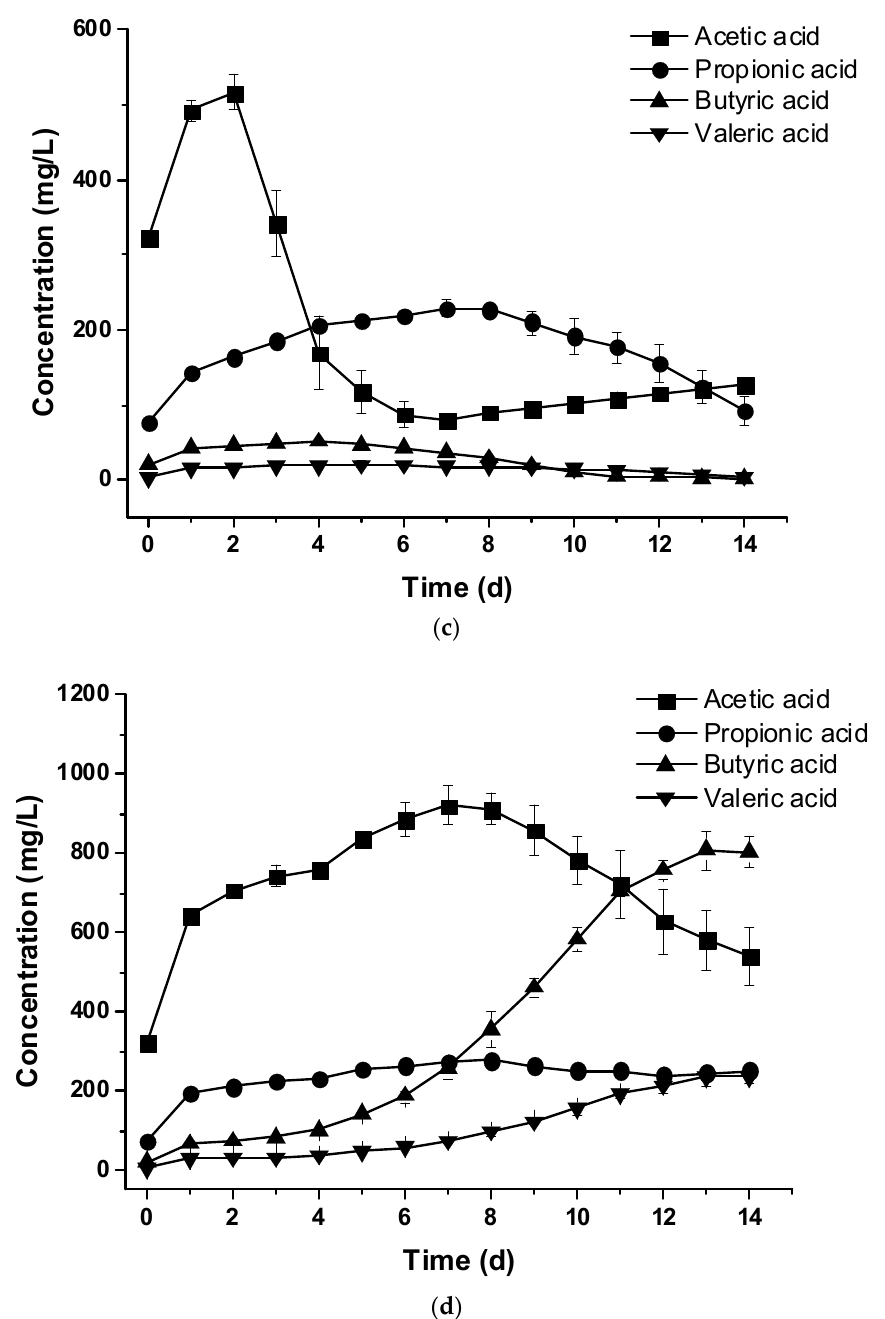
Figure 6. Changes of accumulated volatile fatty acid without ( a ), with 2% ( b ), 4% ( c ), and 8% ( d ) crude glycerol